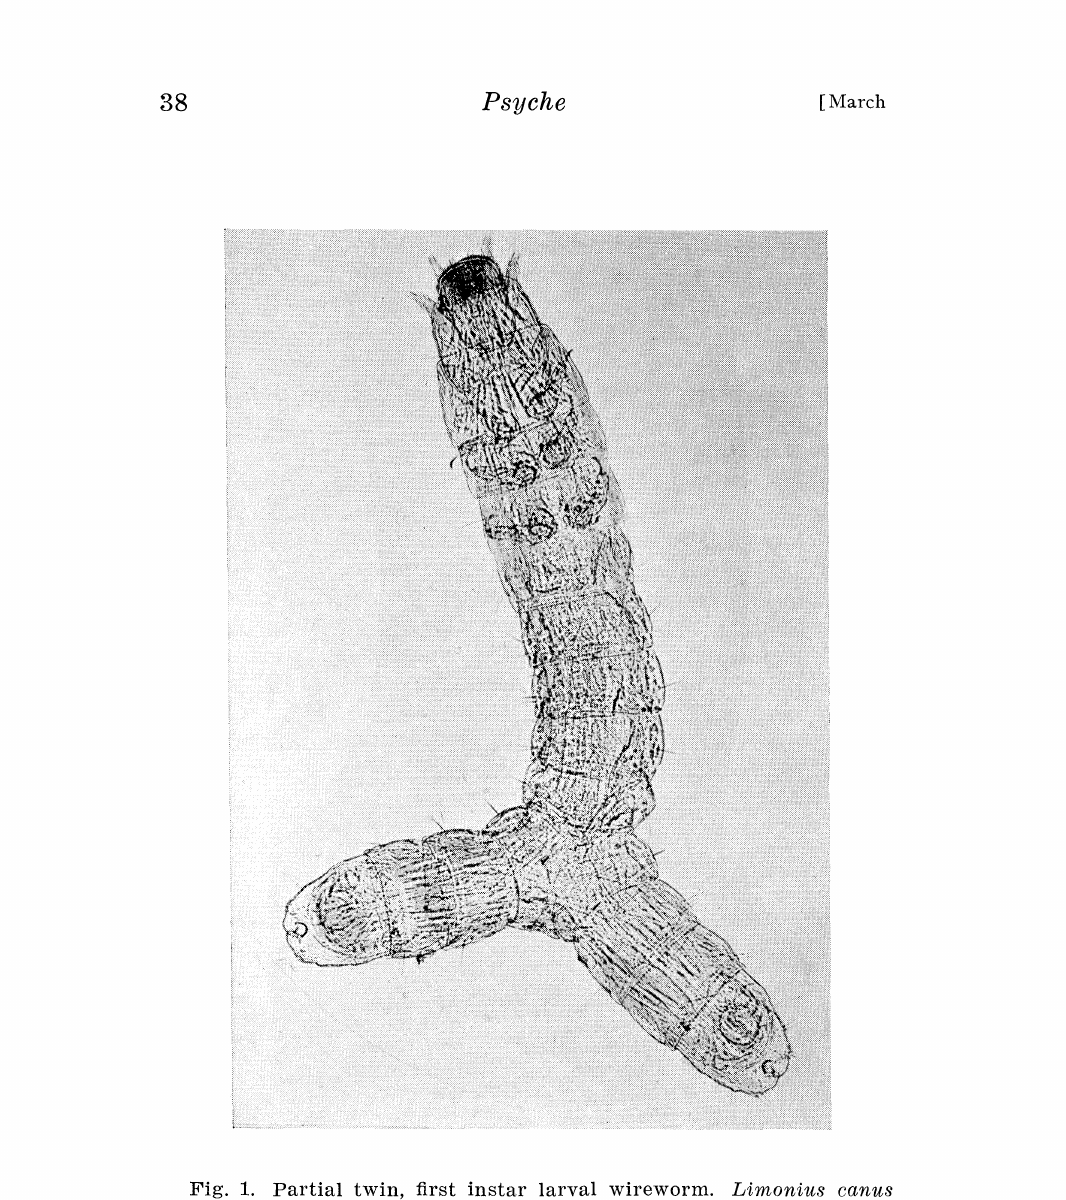
Fig. 1. Partial twin, first instar larval wireworm. Limonius canus Lec., ventral aspect, actual length 2 mm. Enlarged 60